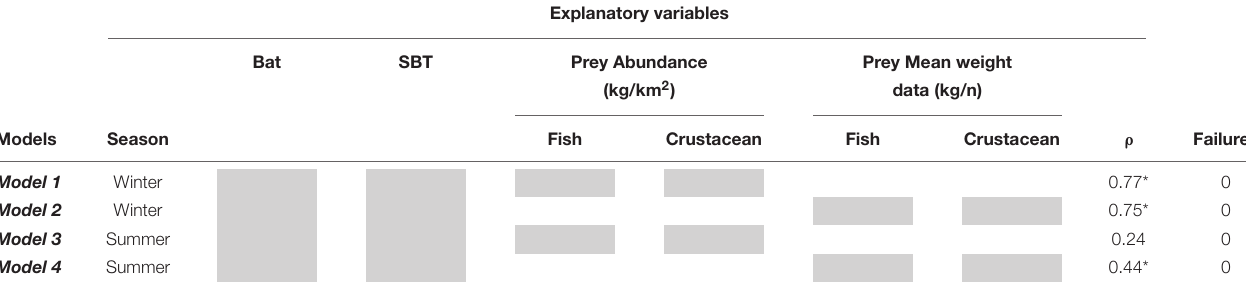
TABLE 1 | Summary table of the four Bayesian species distribution models performed ( Model 1, Model 2, Model 3, and Model 4